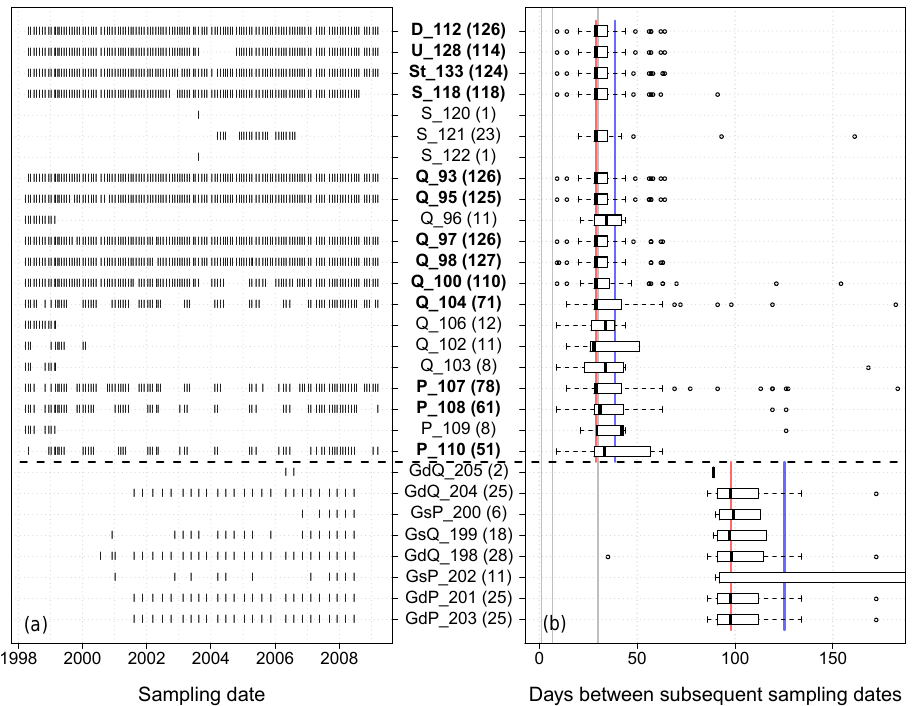
Figure 2. (a) Sampling dates at the sites for the whole monitoring period. (b) Box plots of the variability of sampling intervals during the monitoring period. For better readability, the maximum of the x axis is limited to 180 days. The median (red) and mean (blue) of sampling intervals are shown separately for the groundwater and stream water sites. Grey vertical lines mark the 1-day, 1-week and 1-month interval. (a, b) The dashed horizontal line separates groundwater sites (bottom) from stream water sites (top). Labels: P, Peege; Q, Quillow; S, Strom; St, Stierngraben; U, Ucker; D, Dauergraben; Gs, shallow groundwater; Gd, deep groundwater. The number of samples at each site is given in brackets. Names of the sites with more than 50 samples are printed